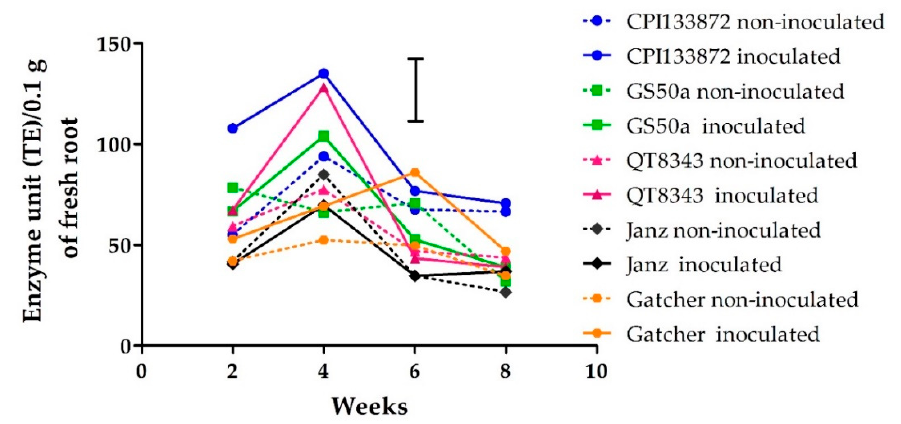
Figure 4. Polyphenol oxidase activity (tyrosinase equivalent (TE) / 0.1 g fresh root) from 2–8 weeks in the roots of Pratylenchus thornei inoculated (solid line) and non-inoculated (dotted line) resistant wheat genotypes—CPI133872 (blue), GS50a (green), and QT8343 (red)—and susceptible wheat genotypes—Janz (black) and Gatcher (orange). The values are the means of three replicates. The bar marker indicates LSD = 33 ( p = 0.05) for the interaction genotype* P. thornei *